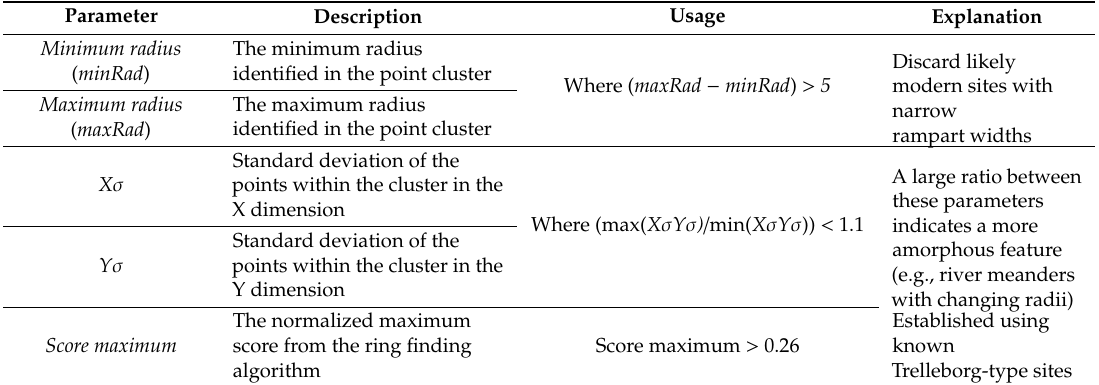
Table 1. Parameters used to refine classified rings.